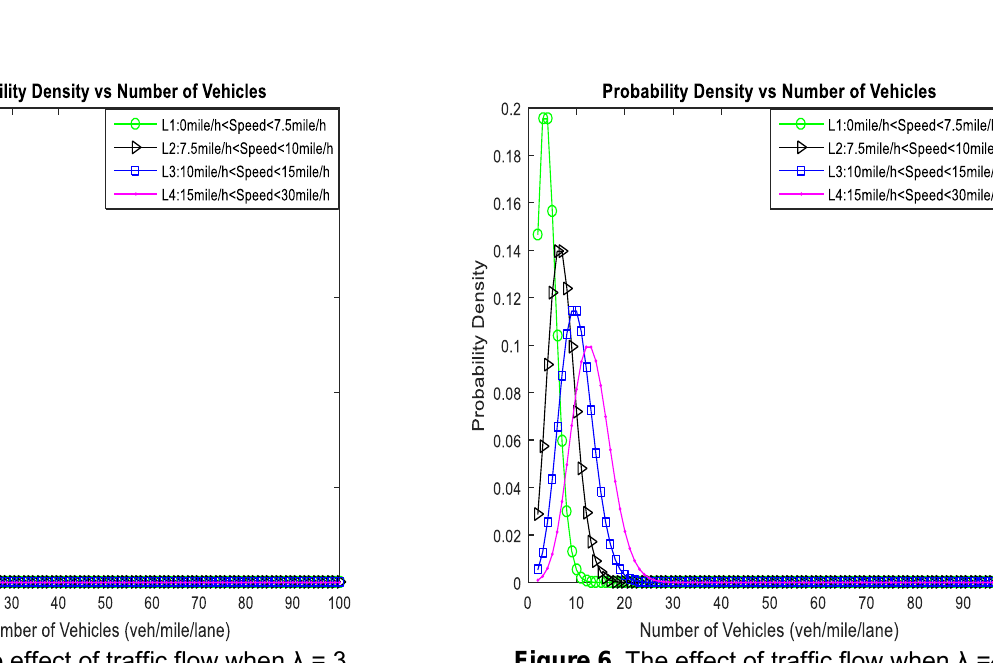
Figure 5. The effect of traffic flow when λ = 3 Figure 6. The effect of traffic flow when λ